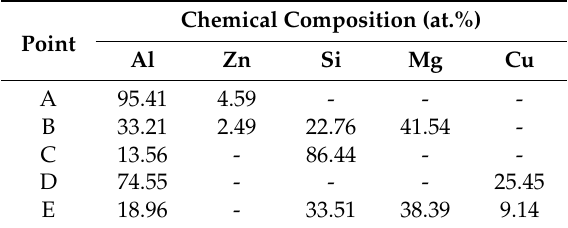
Table 3. Energy dispersive spectrometry (EDS) analysis of the constituent phases in Figure 4 (atom fraction,